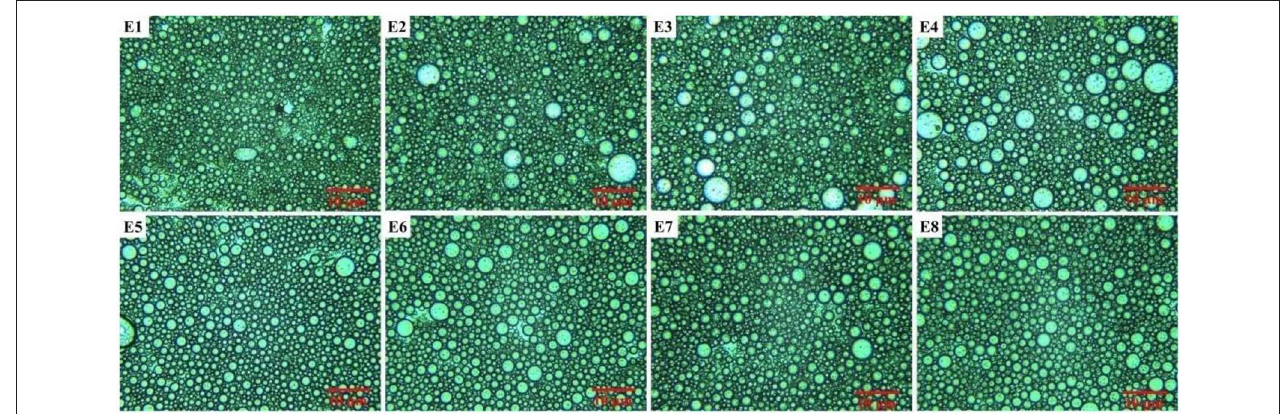
FIGURE 3 | Optical microscope images of Pickering emulsions prepared with different oil phases.